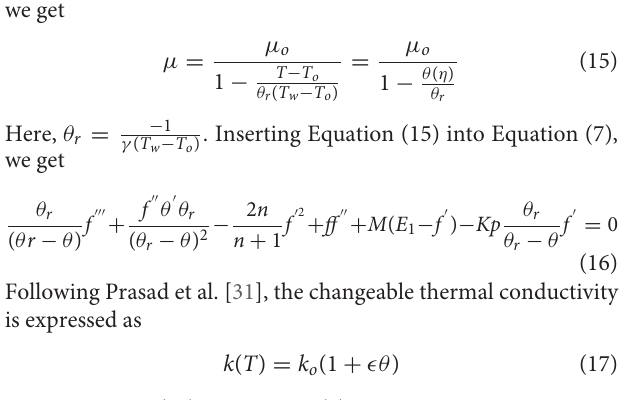
µ o C p is the permeability constant. Pr o = is Kp = 2 ν K o U o ( n + 1) k o the Prandtl number, Nb = τ D B ( C w − C ∞ ) is the Brownian motion ν parameter, Nt = τ D T ( T w − T ∞ ) is the thermophoresis parameter, T ∞ ν ∗ T 3 2 ∞ w Ec = U is the local Eckert number, Rd = 4 σ C p ( T w − T ∞ ) k o k ∗ is the heat source denotes the radiation parameter, s = Q o ( x + b ) ρ u w C p is Lewis number parameter, B i is the Biot number, and Le = ν D B Irfan et al.